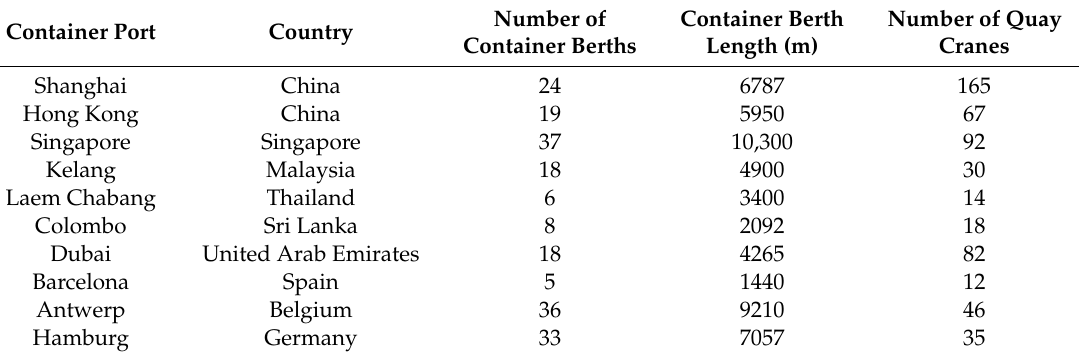
Table 1. Input variables of the 10 container ports along the Maritime Silk Road